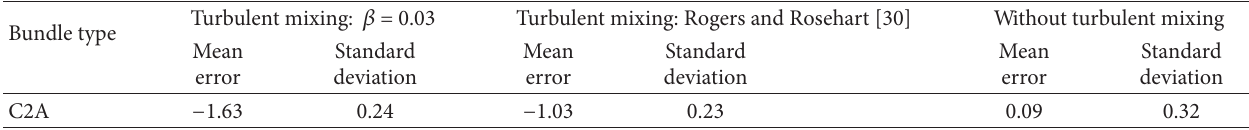
T 6: Statistical analysis for the BFBT test assembly C2A.